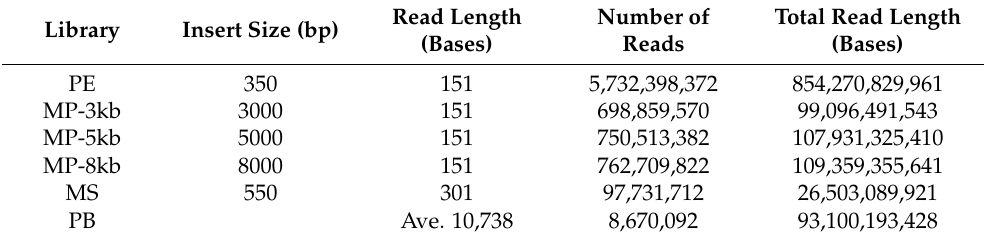
Table 1. Statistics of sequence